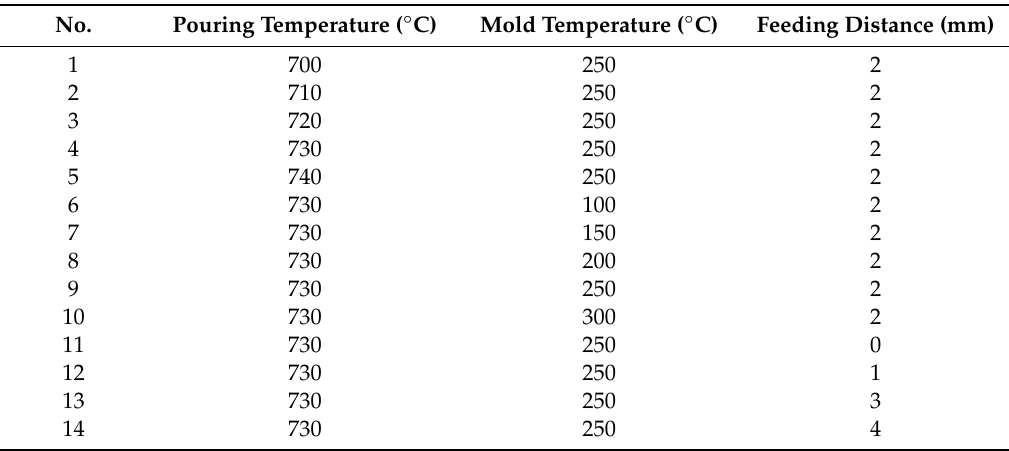
Table 3. Experimental schematic.